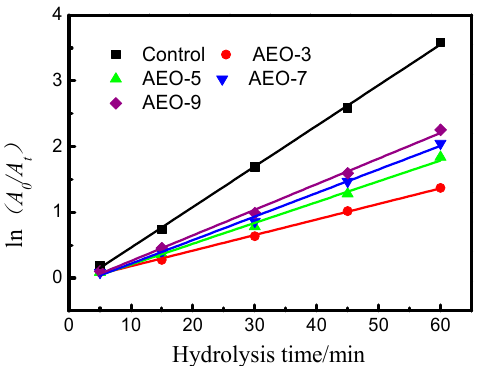
Figure 5. Plot of ln( A o /A t ) verses time at various ethylene oxide content in siloxane non-aqueous dyeing system.